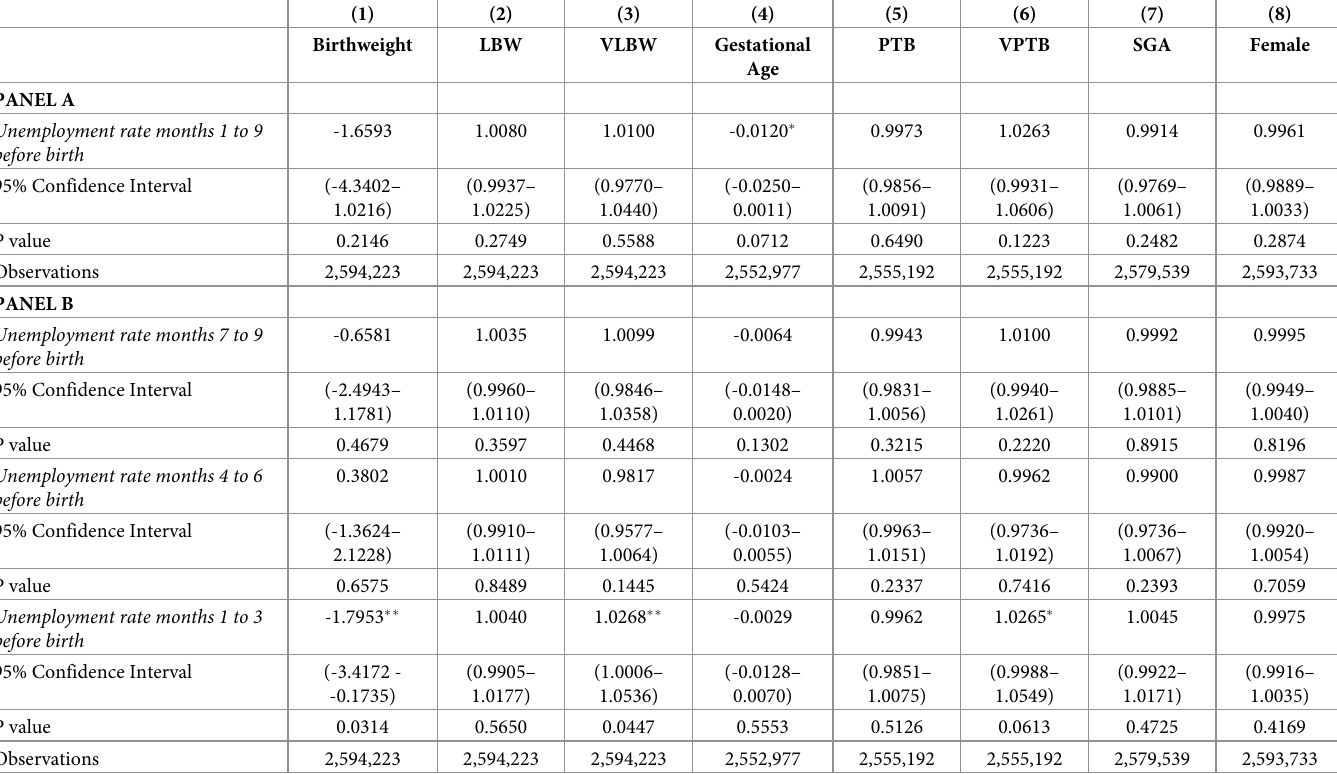
Table 2. Unemployment rate at the mother city of residence and birth